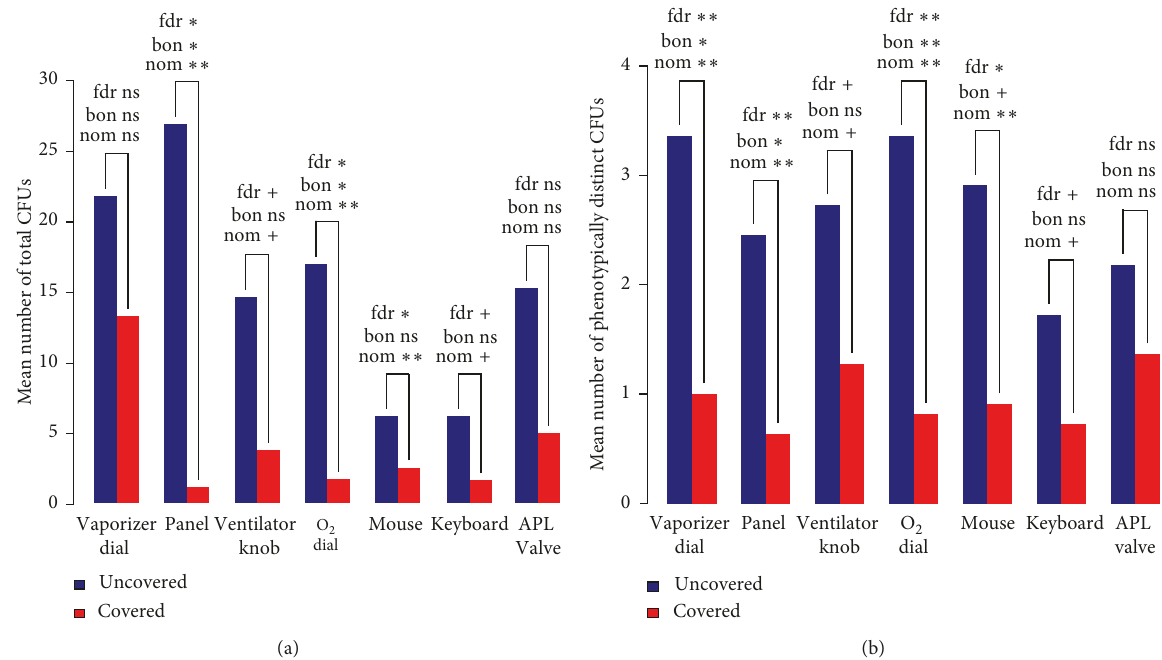
Figure 2: Graphic depiction of CFUs and new species added to each of the hot spots. (a) Density of CFUs. (b) Diversity of CFUs. (a) depicts the differences in the density of CFUs between the AMW and no AMW conditions for each “hot spot”. At each “hot spot,” there were fewer overall CFUs in the AMW cases compared to those where the AMW was not employed. Likewise, there are fewer additional bacterial species added to the individual hot spots, suggesting that the AMW was protective against contamination of the anesthesia machine from previous patients cared for, likely by preventing the anesthesia provider from serving as a vector. To account for multiple testing, nominal unadjusted p values, Bonferroni-adjusted p values, and FDR q values are presented. CFUs